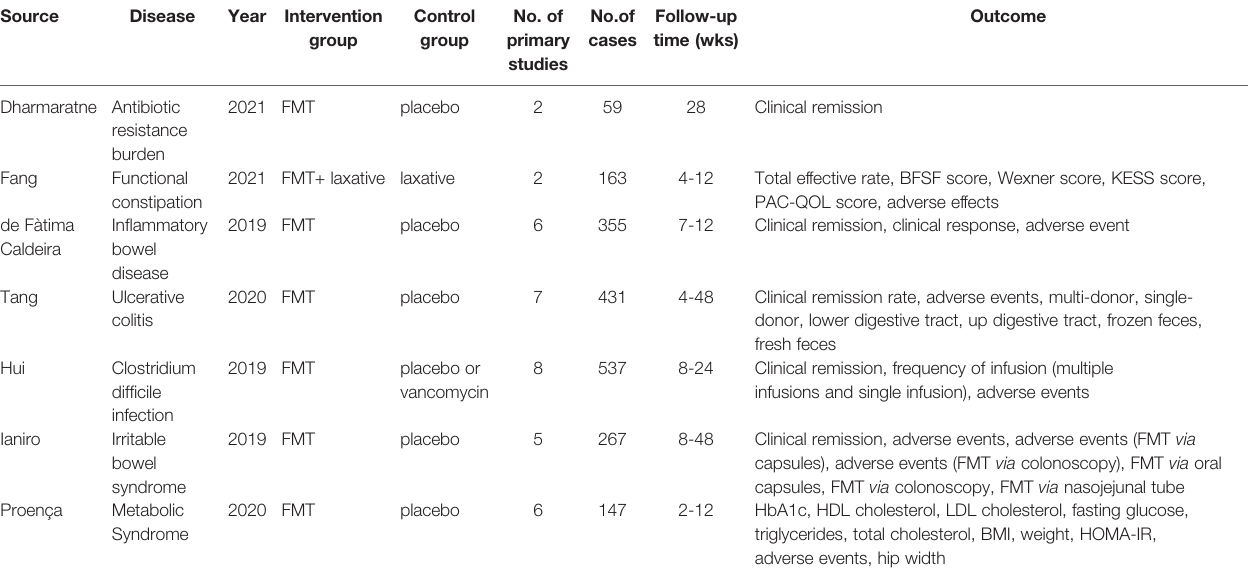
TABLE 1 | The general characteristics of the included